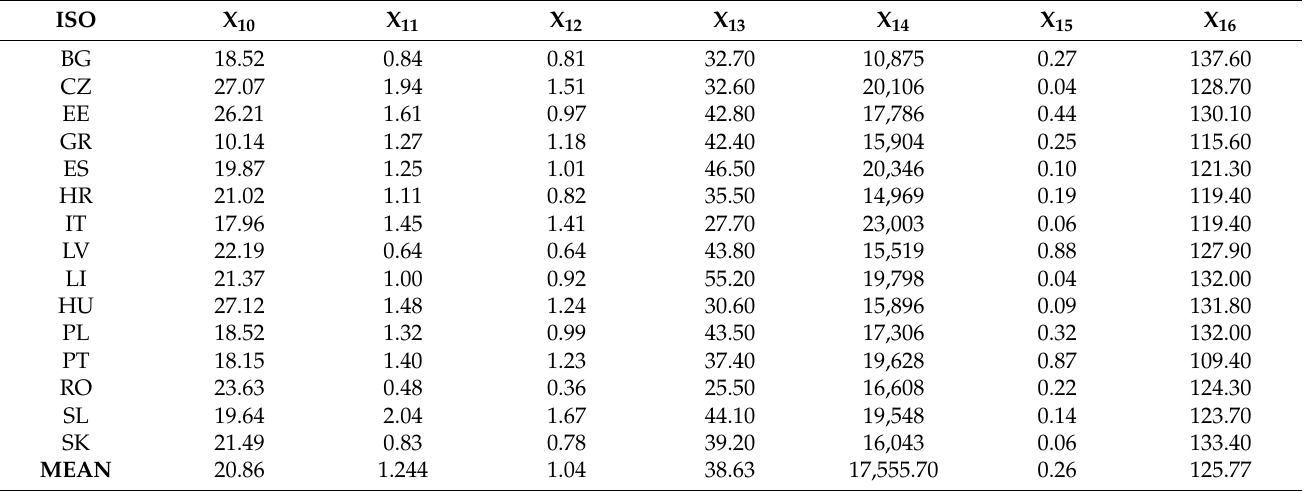
Table 10. “Macroeconomic heterogeneity”—values of diagnostic variables for countries constituting cluster 2.